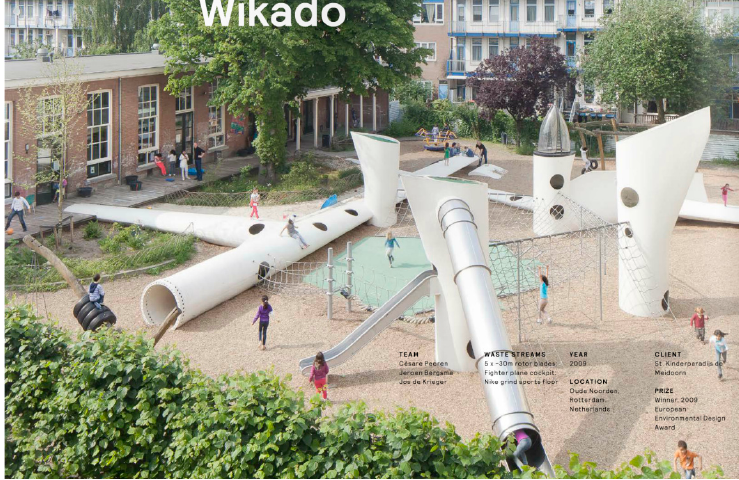
Figure 10. Playground design by the SuperUse studio [129].